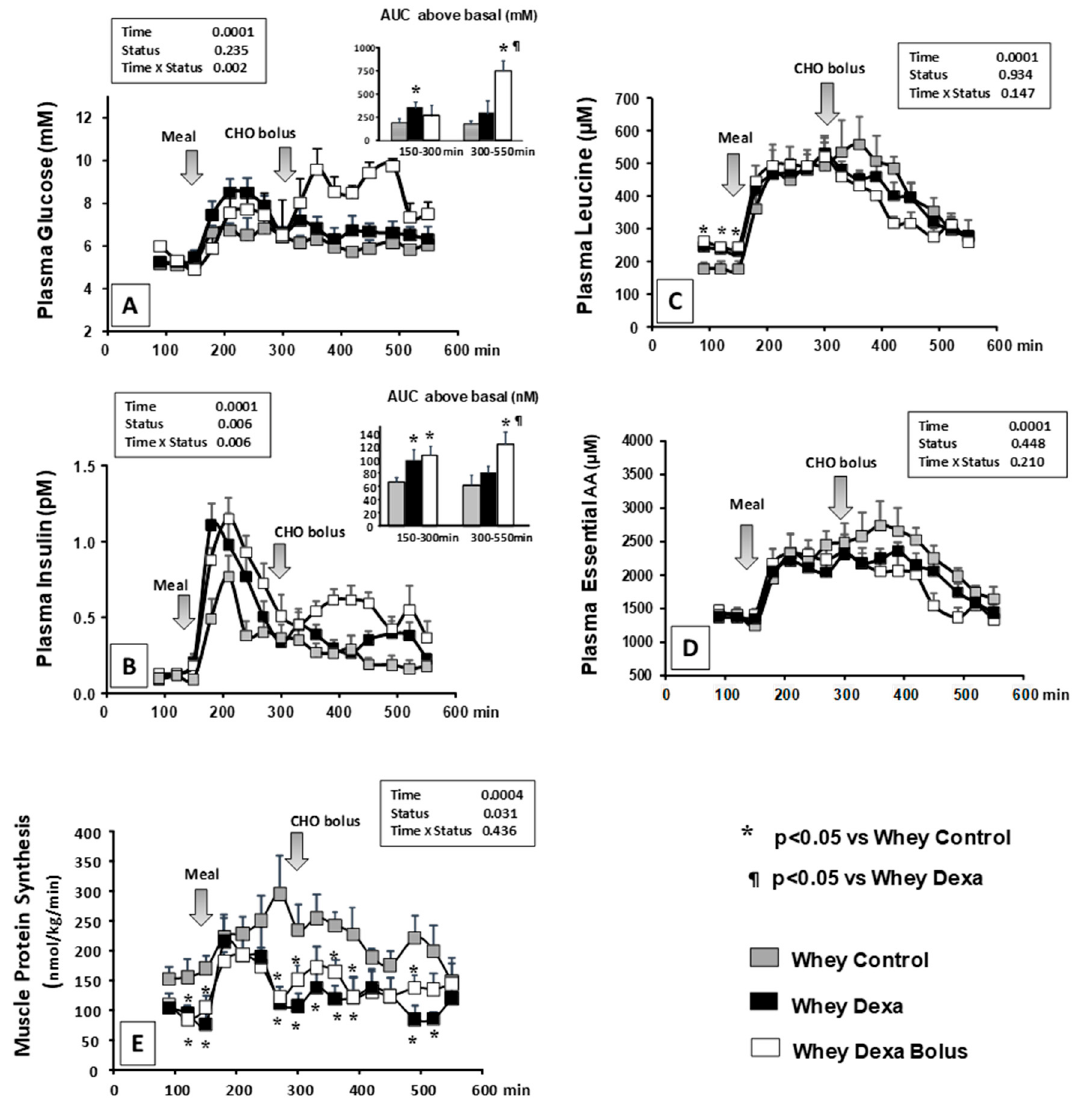
Figure 1. Plasma glucose ( A ), insulin ( B ), leucine ( C ) and essential amino acids ( D ) in control (WHEY CONTROL), in glucocorticoid-treated (WHEY DEXA) and in glucocorticoid-treated with the carbohydrates (CHO) bolus (WHEY DEXA BOLUS) minipigs. The areas under the curve (AUC) for glucose and insulin are presented in inserts. Postprandial AUCs were calculated by subtracting the post-absorptive values (t = 90–150 min) to each postprandial values. ( E ): Muscle protein synthesis kinetics for the post-absorptive period (before t = 150 min) and after the meal (after 150 min) in control (WHEY CONTROL), in glucocorticoid-treated (WHEY DEXA) and glucocorticoid-treated + carbohydrate (CHO) bolus (WHEY DEXA BOLUS) minipigs. The CHO bolus was given at t = 300 min. Data are presented as means ± SEM. ( n = 6).